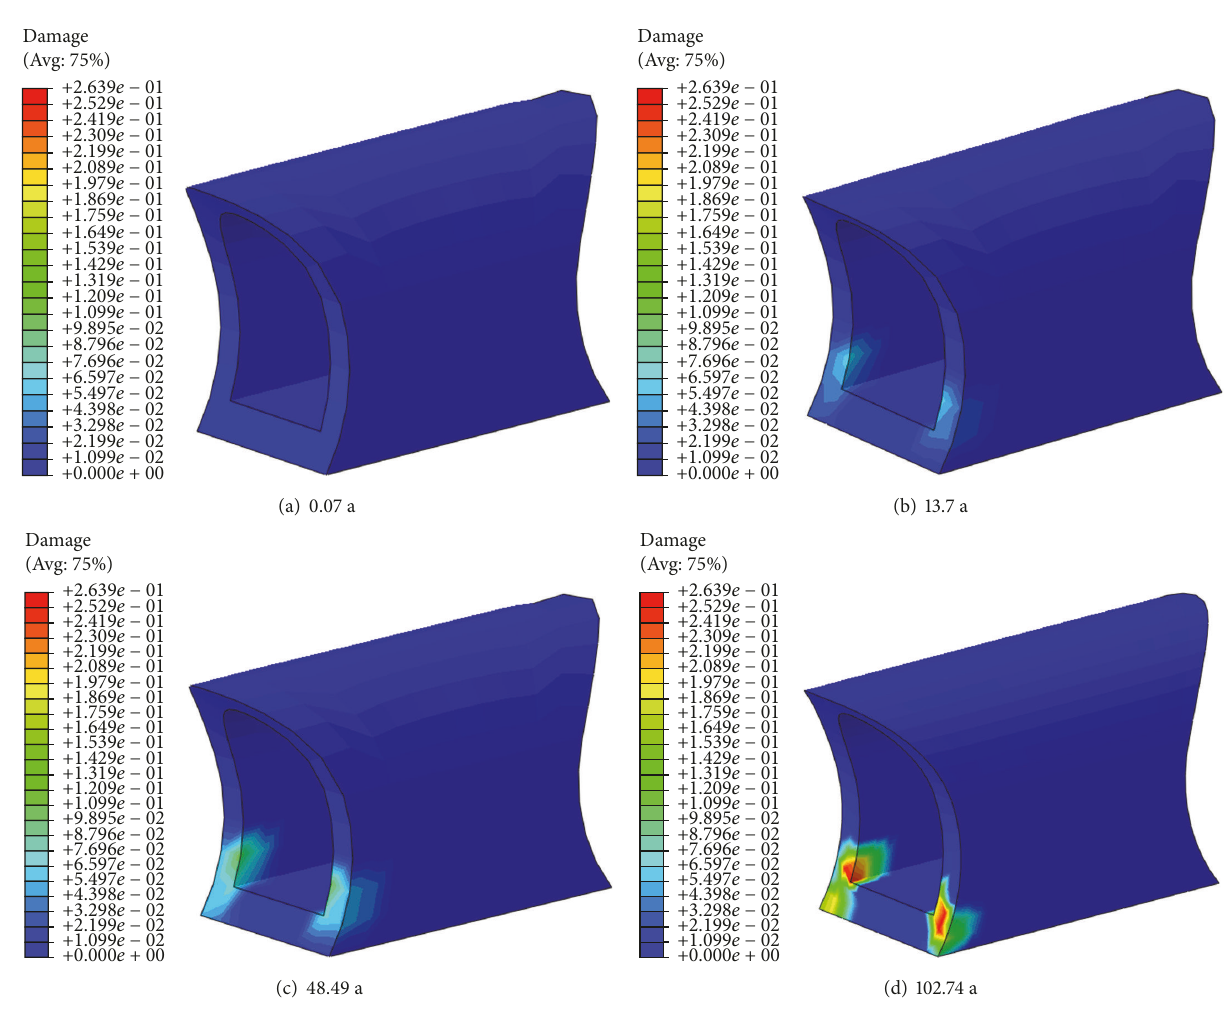
Figure 19: Tensile damage nephogram of the connecting transverse passage at different operation times.